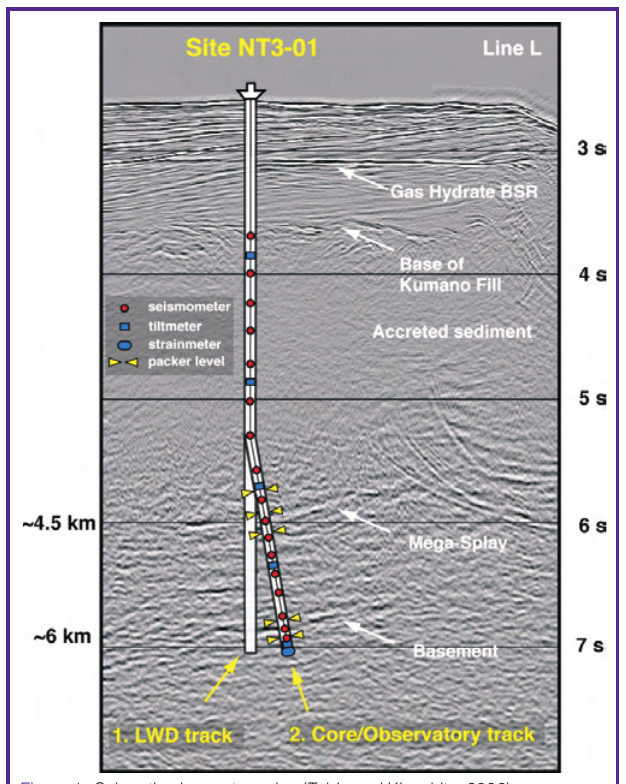
Figure 1. Schemtic observatory plan (Tobin and Kinoshita,